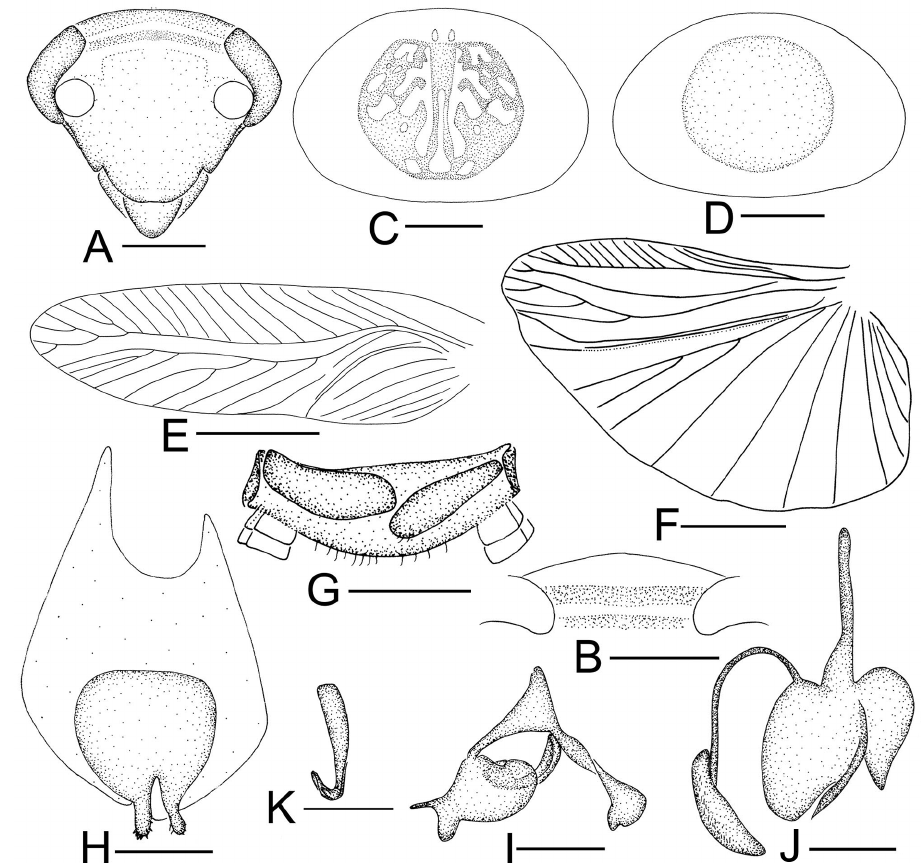
Figure 6. Sorineuchora bivitta (Bey-Bienko, 1969). A–C, E–K male from China, Yunnan, Hekou, Nanxi, Huayudong Forest Park D male from China, Guangxi, Longzhou A head, frontal view B vertex C–D pronotum E tegmen F hind wing (the dotted line indicates wing fold) G supra-anal plate, ventral view H subgenital plate, dorsal view I phallomere L1 J phallomere L2vm and R3 K phallomere R2. Scale bars: 0.5mm ( A–B, G–K ), 1.0 mm ( C, D ), 2.0 mm ( E, F ). dark brownish spot and dense markings consisting of black spots and longitudinal and oblique stripes (Fig. 6C). Abdomen dark red-brown. Legs black-brown. Cerci apex yellowish brown. Interocular space as wide as or narrower than the distance between antennal sockets. Fifth segment of maxillary palpus longer than the fourth. Pronotum subelliptical, anterior and posterior margins nearly truncate. Tegmina and wings fully developed extending beyond end of abdomen, the former with oblique CuA. Hind- wing radial field narrow, R with oblique branches of which some apical ones bifurcated, M bent, without branches or with a small branch at the apex, CuA with three complete branches. Front femur Type C , pulvilli on four proximal tarsomeres, tarsal claws asym- 2 metrical, arolia present. Abdominal terga unspecialized. L1 consisting of several irregu- lar seta-free sclerites (Fig. 6I); L2vm with inflated apex and the left with